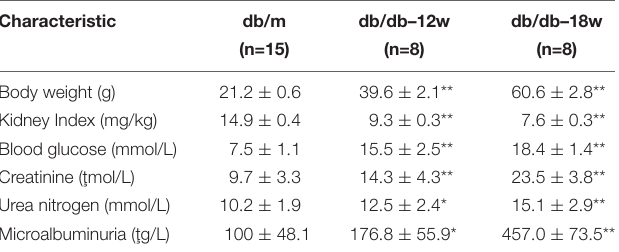
TABLE 1 | Biochemical and physical characteristics of experimental